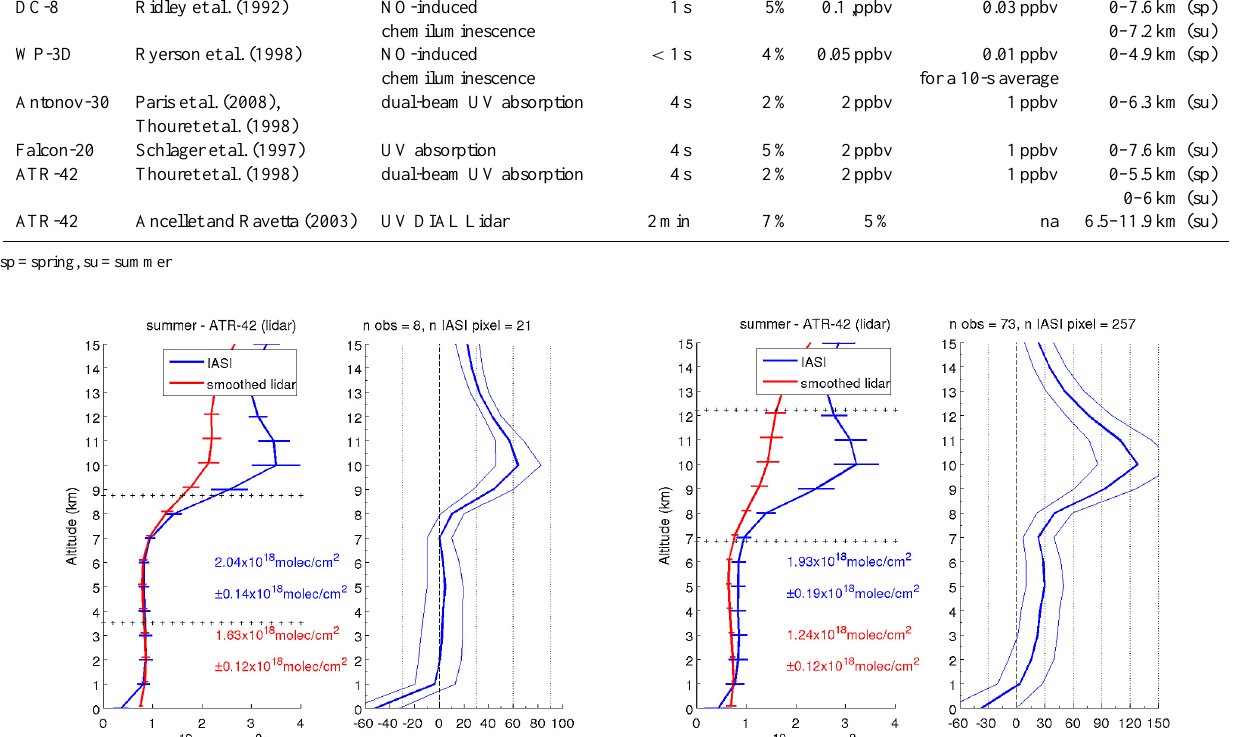
Fig. 8. Left panel: average IASI O 3 profiles (blue lines) and smoothed ATR-42 lidar profiles (red lines) in units of 10 12 moleculescm − 3 . Lidar profiles are separated according to the flight altitude of the ATR-42, below or equal to 4km (a) and above 4km (b) . The upper horizontal dashed black line represents the mean altitude where the lidar profile ends and the climatology starts. The lower horizontal dashed black line represents the mean altitude where the a priori profile ends and the lidar profile starts. Error bars represent the variability of averaged smoothed data (standard deviation ± 1 σ ). The coloured numbers indicate the average [0–12km] column in 10 17 moleculescm − 2 and the standard deviation. Right panel: average relative difference (RD) in % (thick blue lines for profiles and numbers below graphs on the right are the average differences for [0–12km] columns) and ± 1 σ (thin blue lines). The number of lidar observations and IASI co-located pixels are noted at the top right of the panels. The relative differences are calculated as follows: [(IASI – smoothed lidar)/(smoothed lidar)] × 100%. The smoothed lidar profiles are the measurements completed with the ACE-FTS climatology and the a priori profile, and convolved with IASI AK (see text for details). The mean ECMWF dynamical tropopause is at 8.4 and 8.8km,